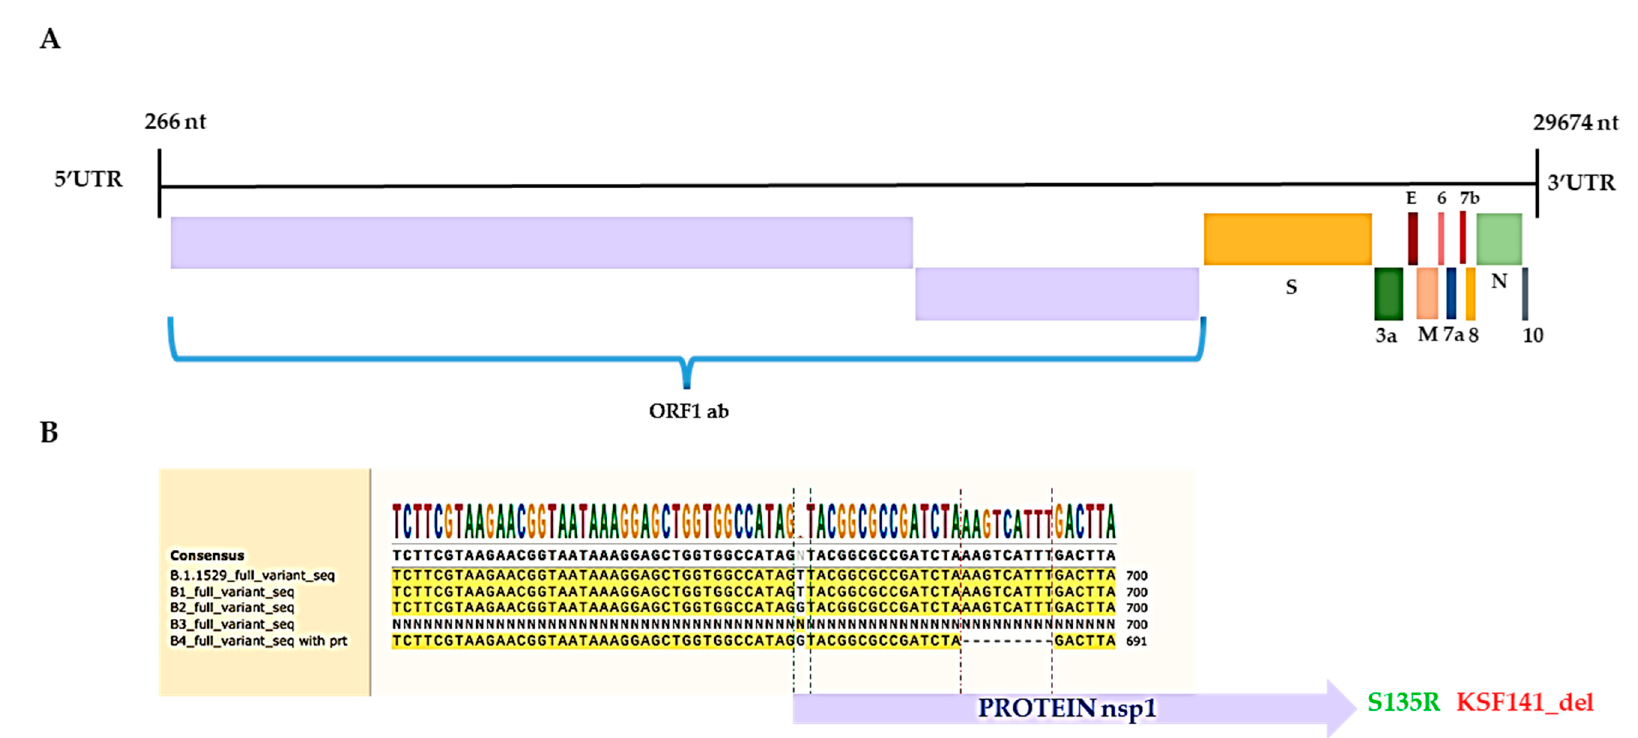
Figure 1. Genome characterization of SARS-CoV-2: ( A ) Schematic representation of SARS-CoV-2 full genome. ( B ) Pictogram of SNAPgene alignment among Omicron lineages.